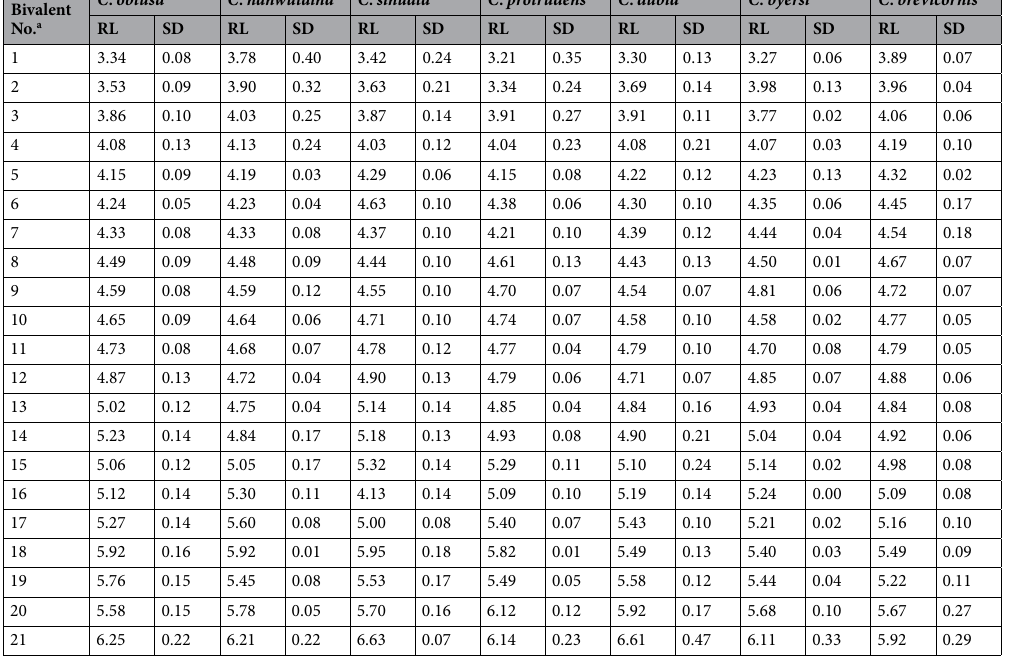
Table 1. Measurement of pachytene bivalents of seven species in Cerapanorpa . RL = relative length; SD = standard deviation. a Bivalents were ordered according to their C-banding pattern as in Fig.